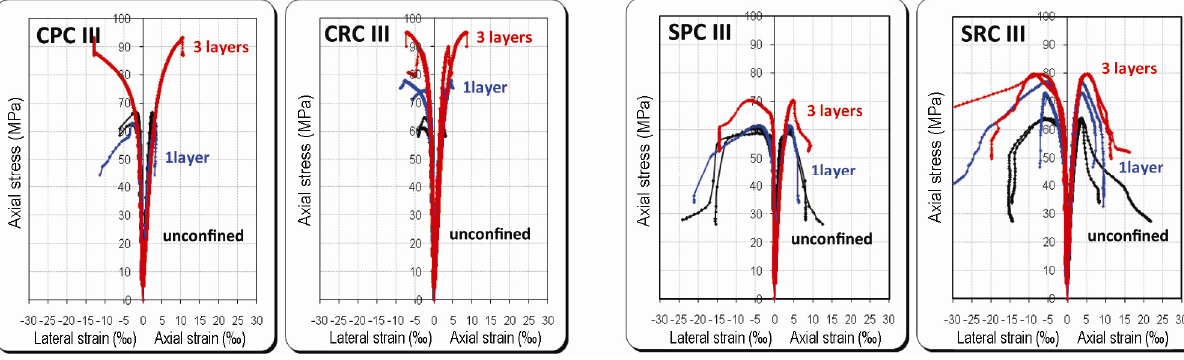
Fig. 10. Experimental stress strain curves of high-strength concrete specimens ( f’ co = 62